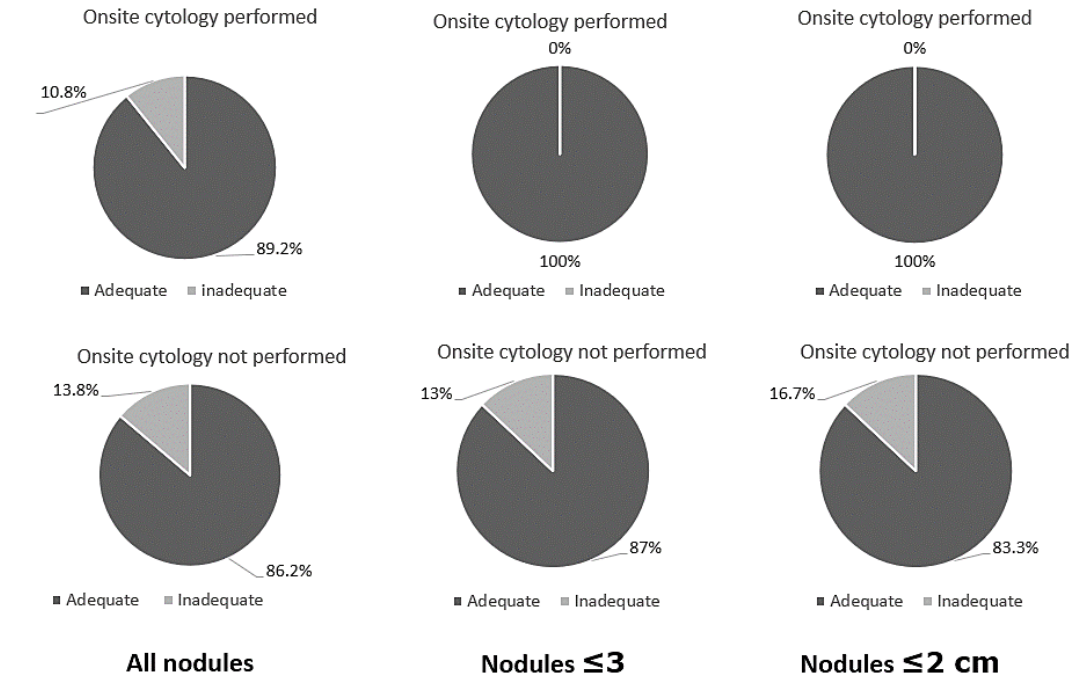
Figure 2. The effect on performing onsite cytological exam on obtaining adequate sample in different nodule